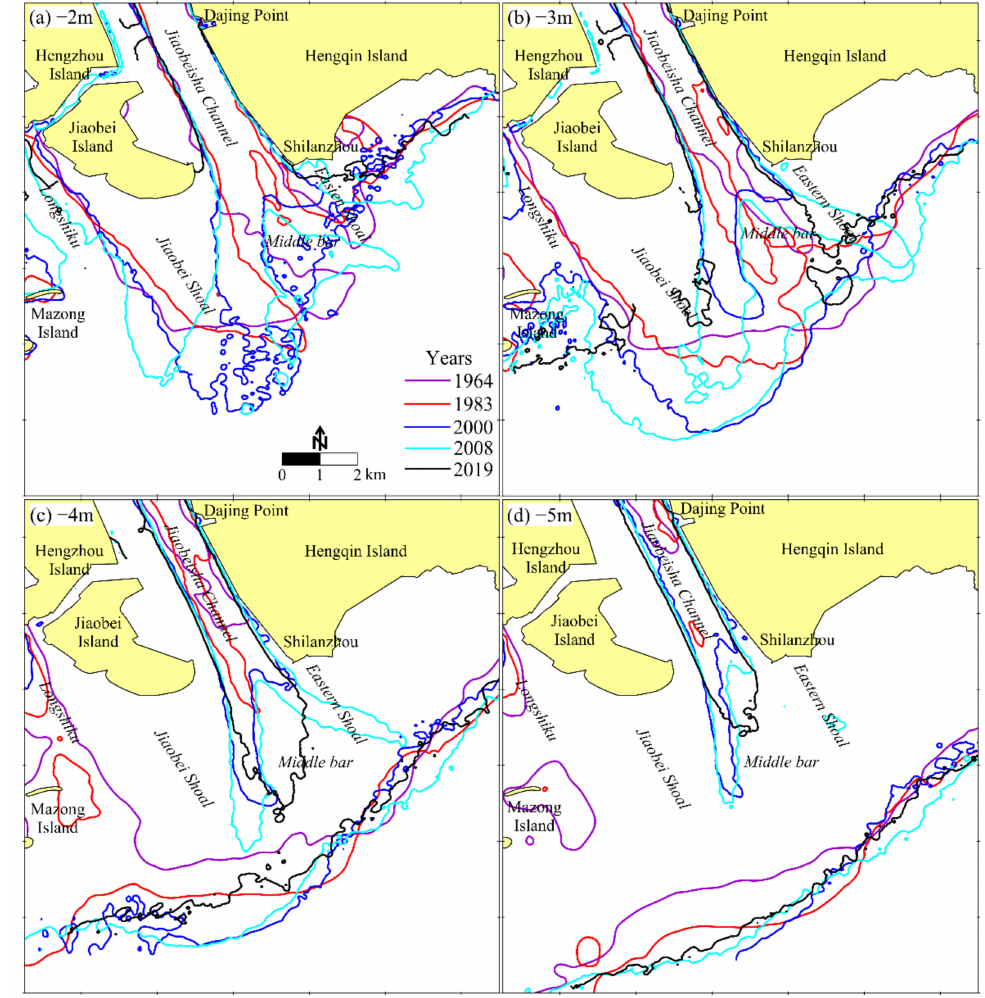
Figure 3. Planar changes of ( a ) − 2 m, ( b ) − 3 m, ( c ) − 4 m, and ( d ) − 5 m isobaths from 1964 to 2019. From 1964 to 1983, the eastern and western Jiaobei Shoal and the deep trough of the Jiaobei Channel experienced a significant scouring process with a scouring range of 0.5–3.0 m (see Figure 4a); Longshiku, the east shoal, and southern Jiaobei Shoal experienced a significant silting process with a silting range of 0.5–2.0. There was slight siltation on the east side of the mouth bar. Overall, the mouth bar maintained the geomorphic characteristics of “two shoals with one distributary branch” during this period; the mouth bar moved southward, and the distributary branch inside the mouth bar began to deflect